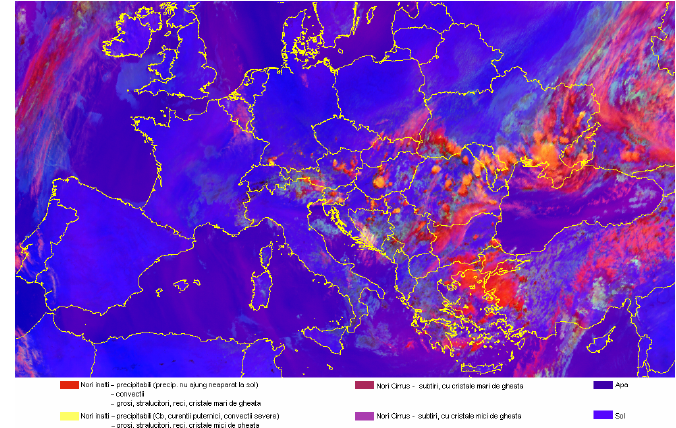
Figure 3 – MSG RGB satellite image for intense convection